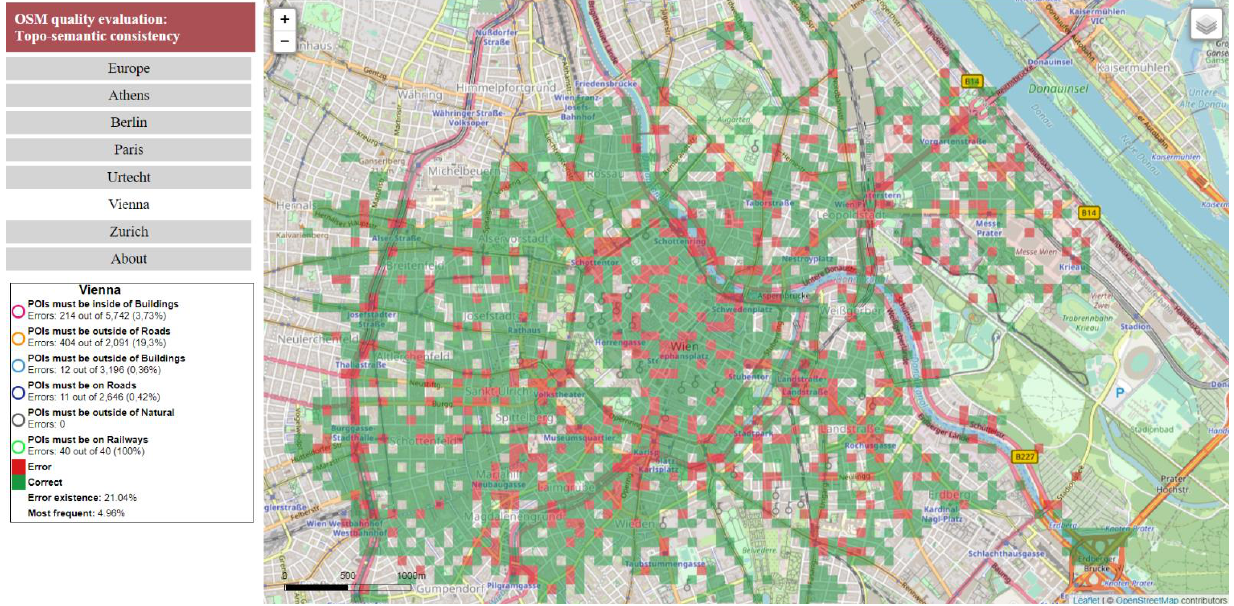
Figure A7. Consistency Grid (error existence) for Vienna.